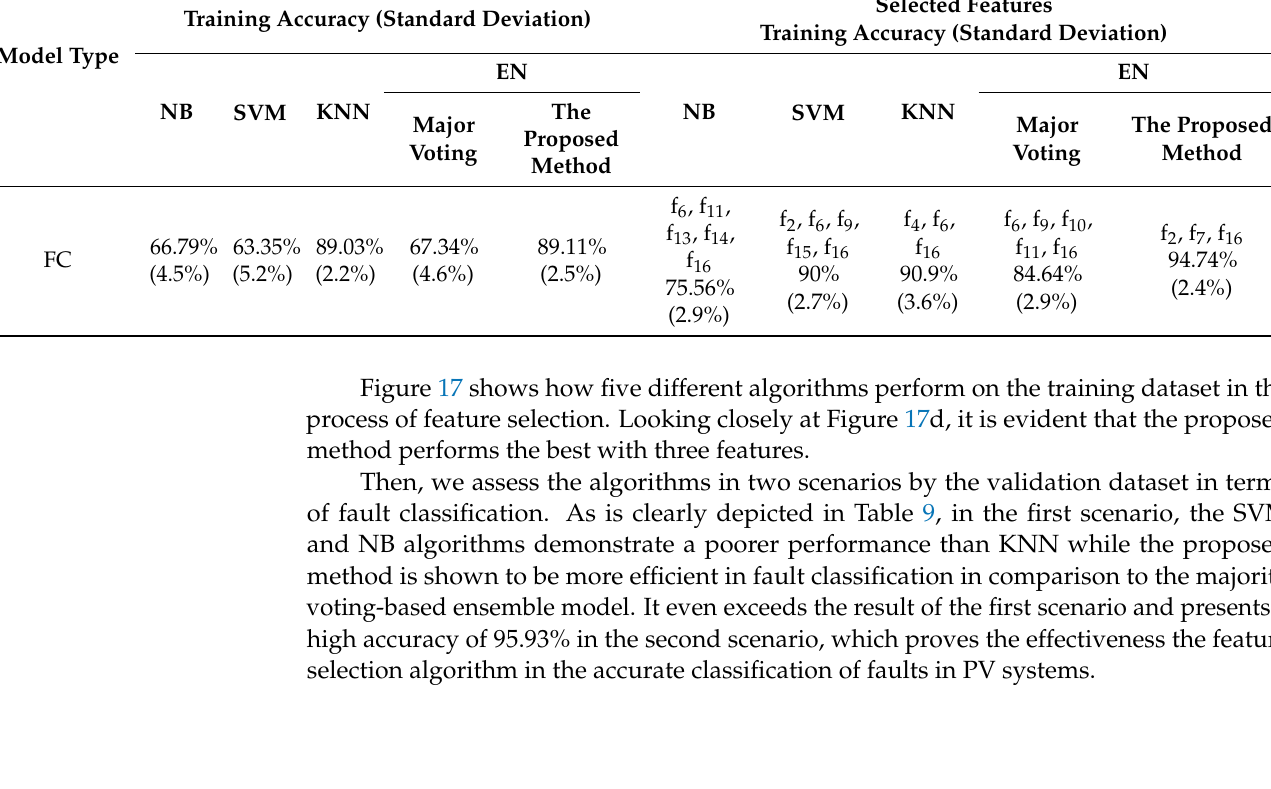
Table 8. The training results of the FC